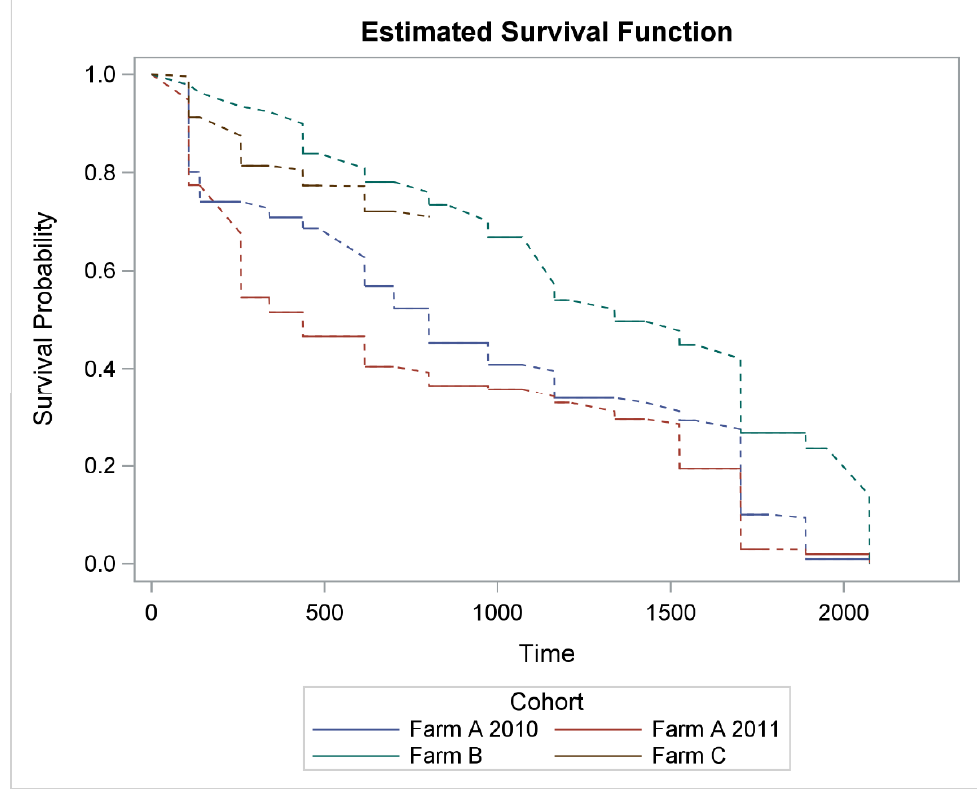
Figure 1. Interval-censored lifetime ewe wastage (combination of premature culling and on-farm mortality) from enrolment (time = Day 0) to Year 6 weaning (time = Day 2074), stratified by cohort (Farm A 2010-born and 2011-born, Farm B and Farm C). The dotted lines denote the uncertainty of when the ewes exited their respective flocks due to the interval-censored nature of the data.